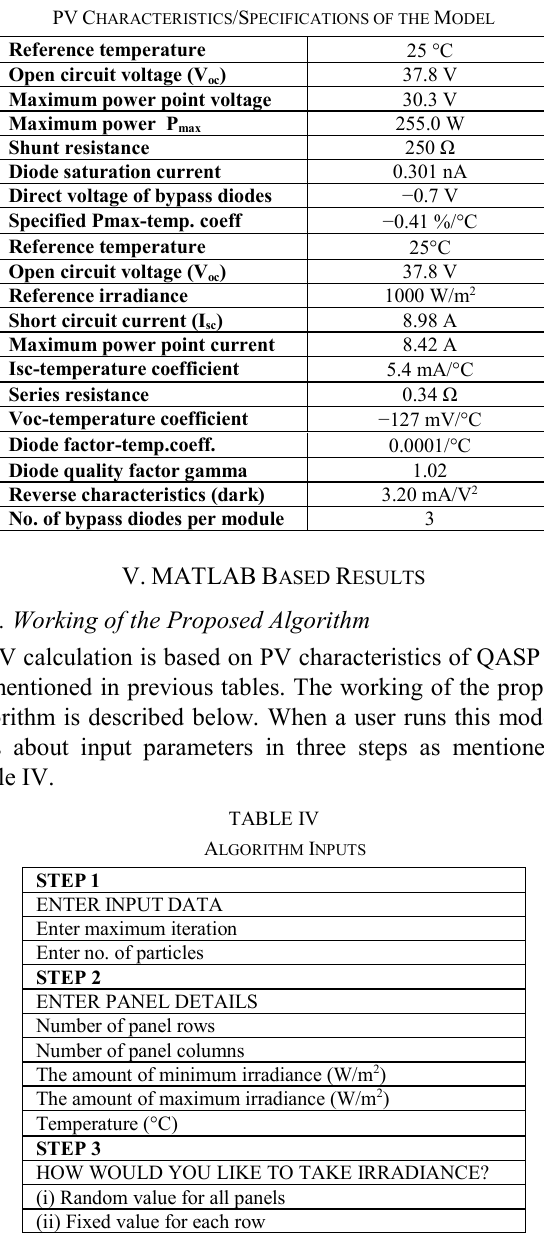
PV C HARACTERISTICS /S PECIFICATIONS OF THE M ODEL